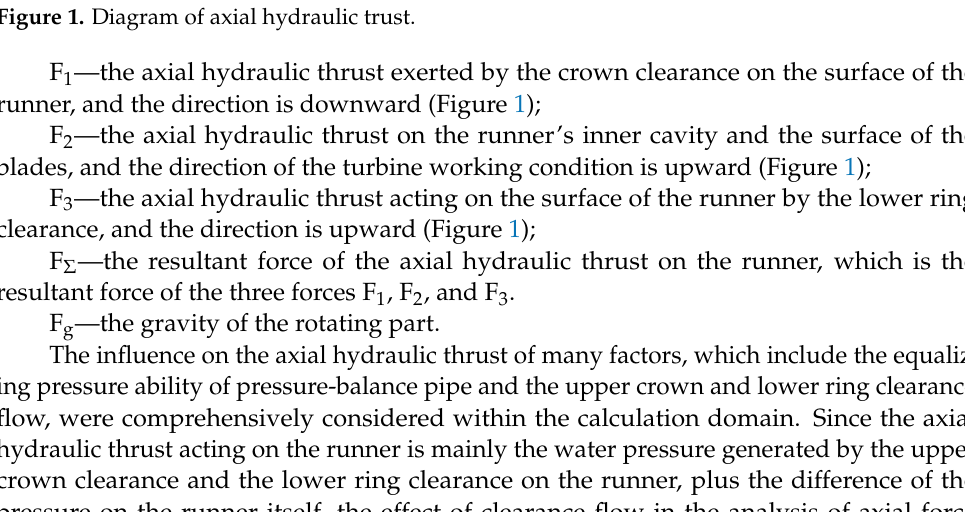
Figure 1. Diagram of axial hydraulic